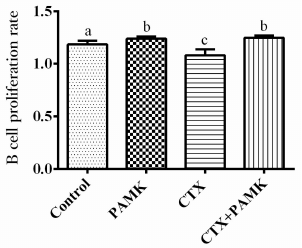
Figure 5. Effects of PAMK on proliferation of B cells from geese treated with CTX. The B-cell proliferation rate. The data are expressed as the mean ± SD, n = 8. Means with different letters represent statistically significant differences ( p < 0.05); the bars with the same letter are not significantly different ( p >